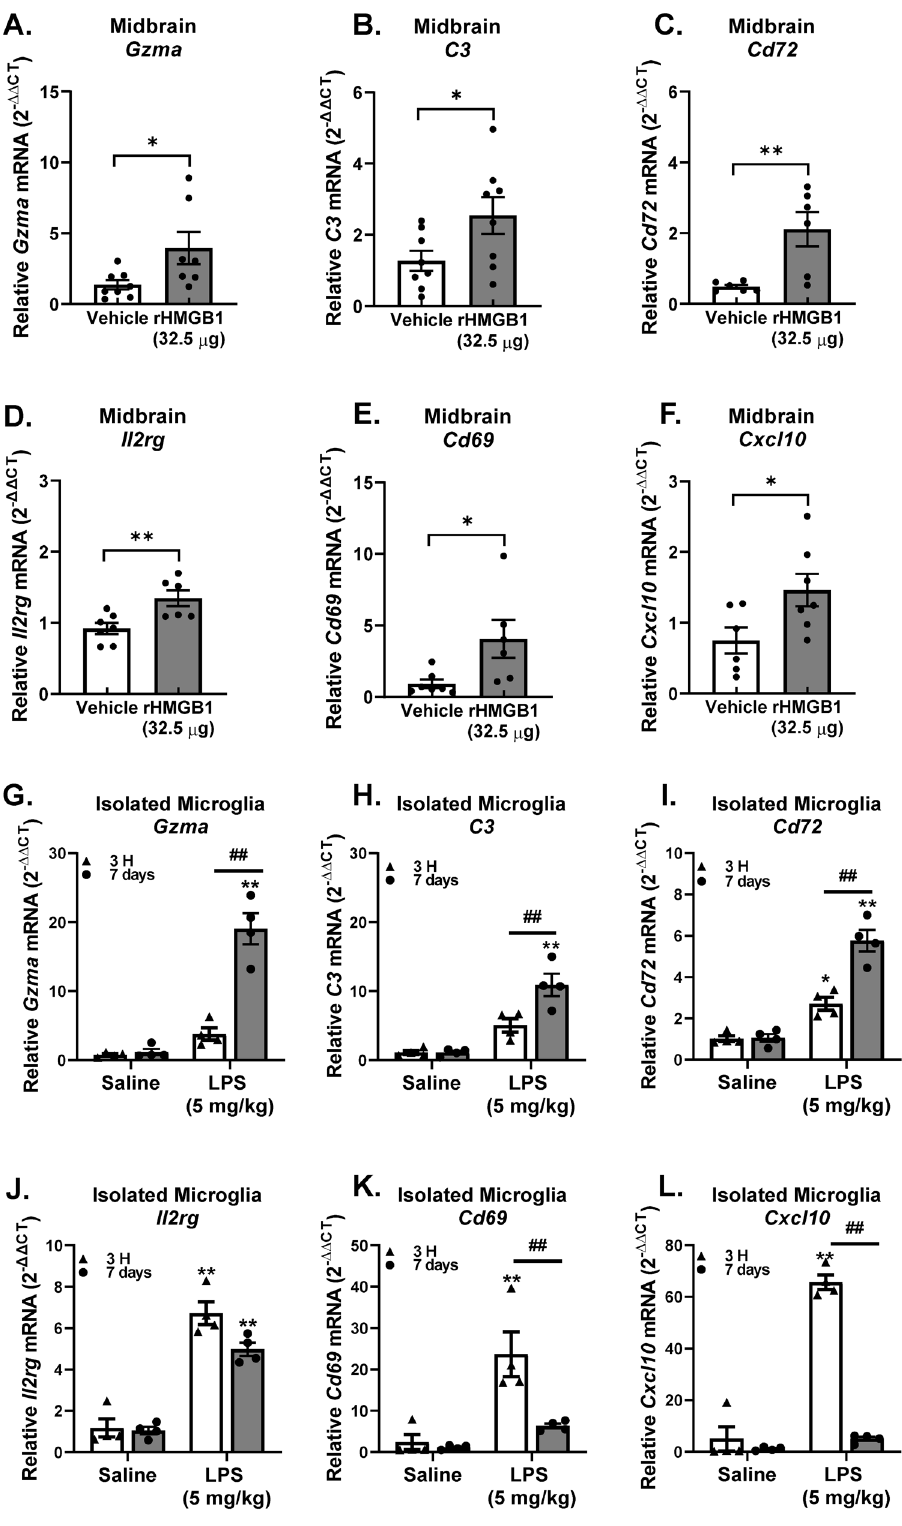
Fig. 5 Intravenous HMGB1 administration elevates persistent pro-in fl ammatory microglia (PPM) genes in the midbrain. C57BL/6 mice received a single IV injection of recombinant HMGB1 protein (rHMGB1, 32.5 μ g) or vehicle and mRNA was assessed in the midbrain 3 H later. PPM transcriptome genes ( A ) Gzma , ( B ) C3 , ( C ) Cd72 , ( D ) Il2rg , ( E ) Cd69 , and ( F ) Cxcl10 mRNA levels were measured in the midbrain. Male C57BL/ 6 mice received a single IP injection of LPS or saline and neuroin fl ammation was assessed 3 H or 7 days later and PPM gene expression levels were compared: ( G ) Gzma , ( H ) C3 , ( I ) Cd72 , ( J ) Il2rg , ( K ) Cd69 , and ( L ) Cxcl10 mRNA levels were measured in the isolated microglia. mRNA levels were analyzed by qRT-PCR and normalized to Gapdh using the 2- ΔΔ CT method. Data are reported as the mean ± SEM. * p < 0.05 and ** p < 0.01 when compared to control ( n = 4 –